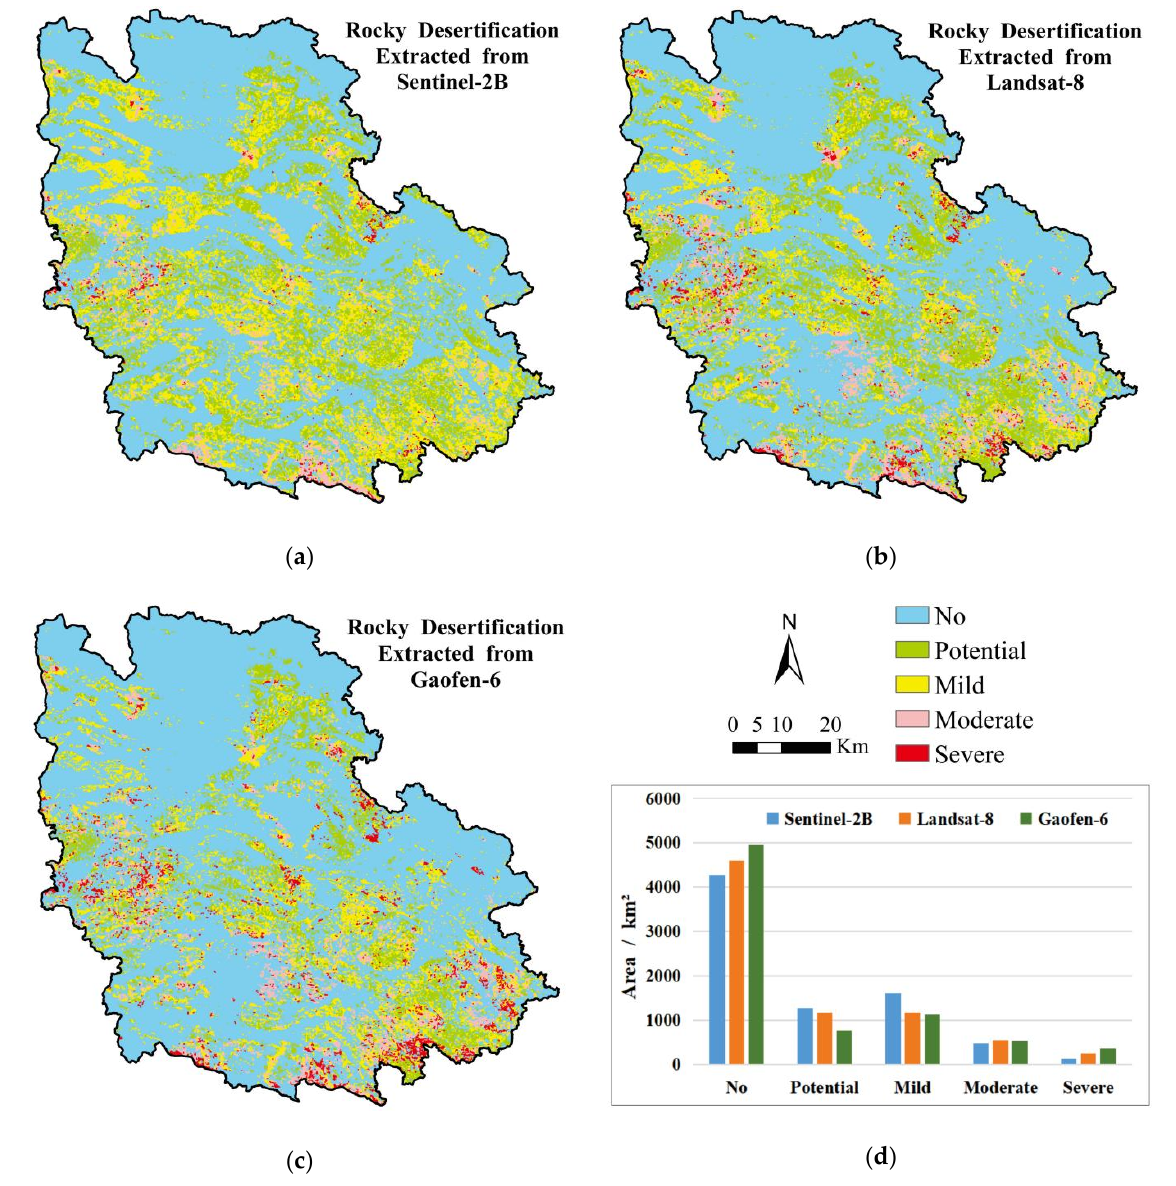
Figure 7. Extraction results of rocky desertification: ( a ) rocky desertification results extracted from Sentinel-2B images; ( b ) rocky desertification results extracted from Landsat-8 images; ( c ) rocky desertification results extracted from Gaofen-6 images; ( d ) the legend and the area of different levels of rocky desertification extracted from three types of images.